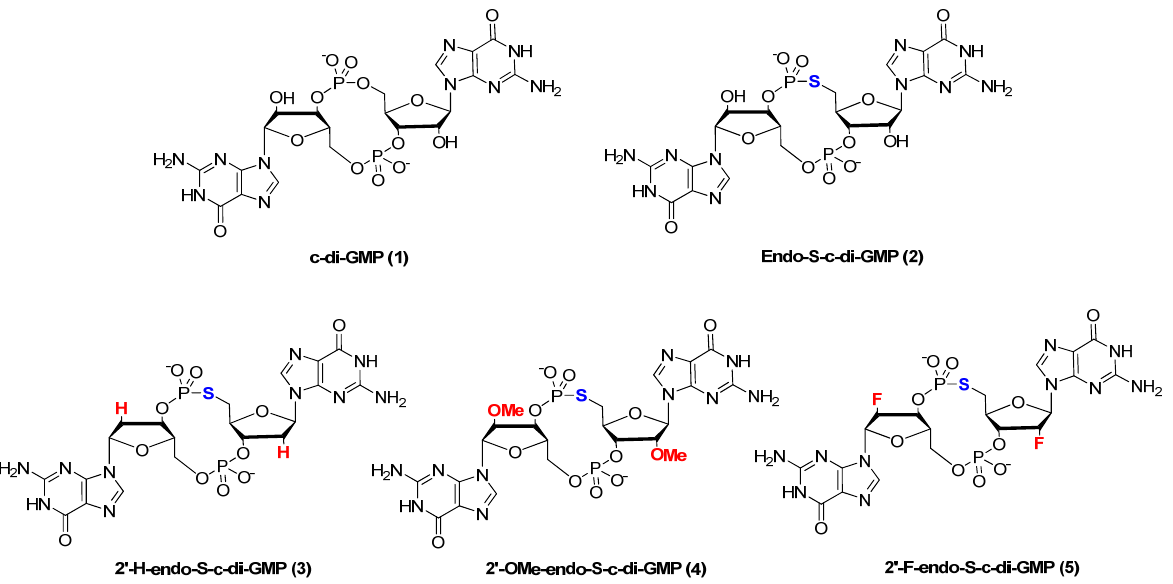
Figure 1. Family of dual-modified c-di-GMP analogues